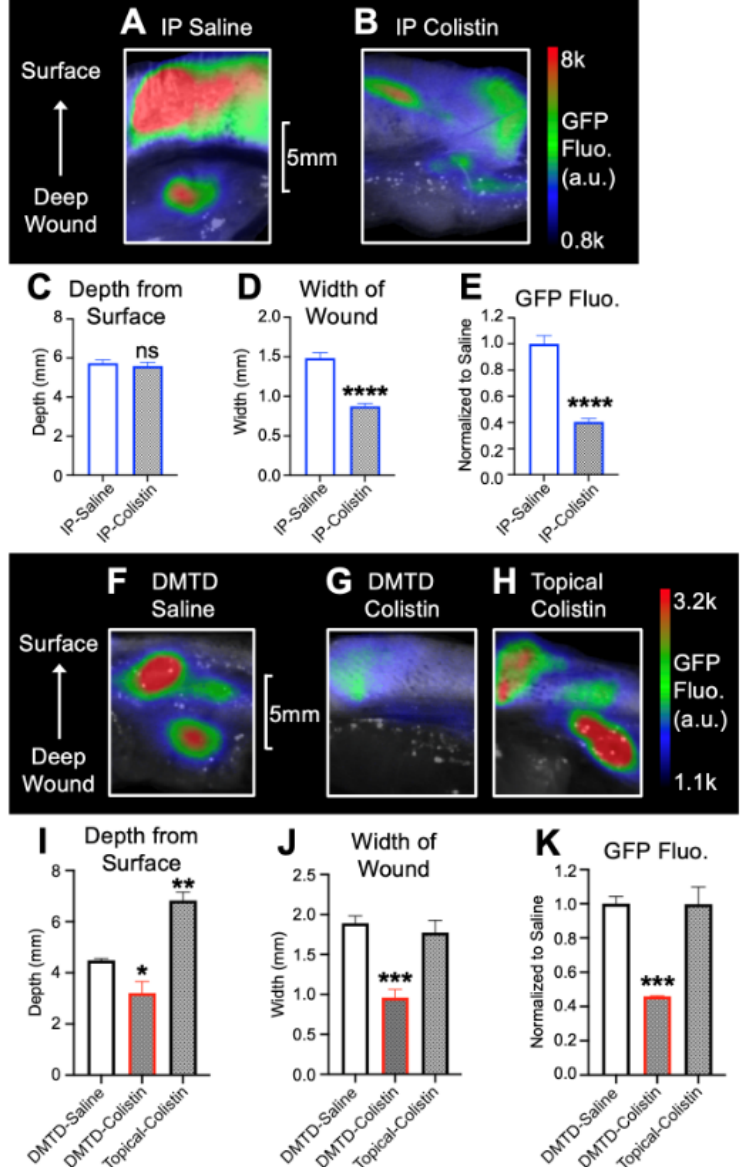
Figure 7. Representative images of rat wound tissue infected with GFP- E. coli and treated with intraperitoneal saline (IP-saline: ( A )) or CMS (IP-colistin: ( B )). The depth of the wound from the top of the skin (surface) is marked. Histograms ( C , D ) show the changes in the depth and width of infection after IP-colistin treatment and ( E ) shows the overall intensity of the GFP fluorescence in IP-colistin wounds compared to IP-saline wounds (normalized to IP-saline wounds). ( F , G ) show representative images of rat wound tissue infected with GFP- E. coli and treated with the micromist delivered by DMTD that carries either saline (( F ): DMTD saline), or CMS dissolved in saline (( G ) DMTD colistin) to the deep skin tissue. ( H ) (Topical colistin) shows representative image of wound tissue infected with GFP- E. coli and treated with CMS (same dose) delivered on top of the skin by a micropipette and retained on the skin (above the infected wound) by a barrier created by ophthalmic ointment. Histograms ( I , J ) show the changes in the depth and width of infection after treatments with DMTD- delivered micromist carrying saline or CMS. Histogram ( K ) shows the overall intensity of the GFP fluorescence in wounds treated with DMTD-colistin compared to DMTD-saline or topical colistin treatments (normalized to DMTD-saline wounds). n = 6 for each treatment group in ( A – E ). n = 5 for each treatment group in F-K. fluo.: fluorescence a.u: arbitrary units. * p < 0.05; ** p < 0.01; *** p < 0.001, **** p < 0.0001, ns: not significant p >